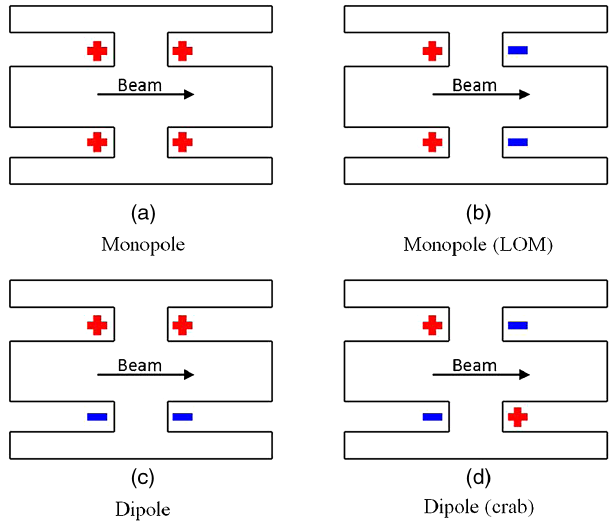
FIG. 9. Sketches of the rod polarity configurations for the monopole and dipole modes in a 4RCC.